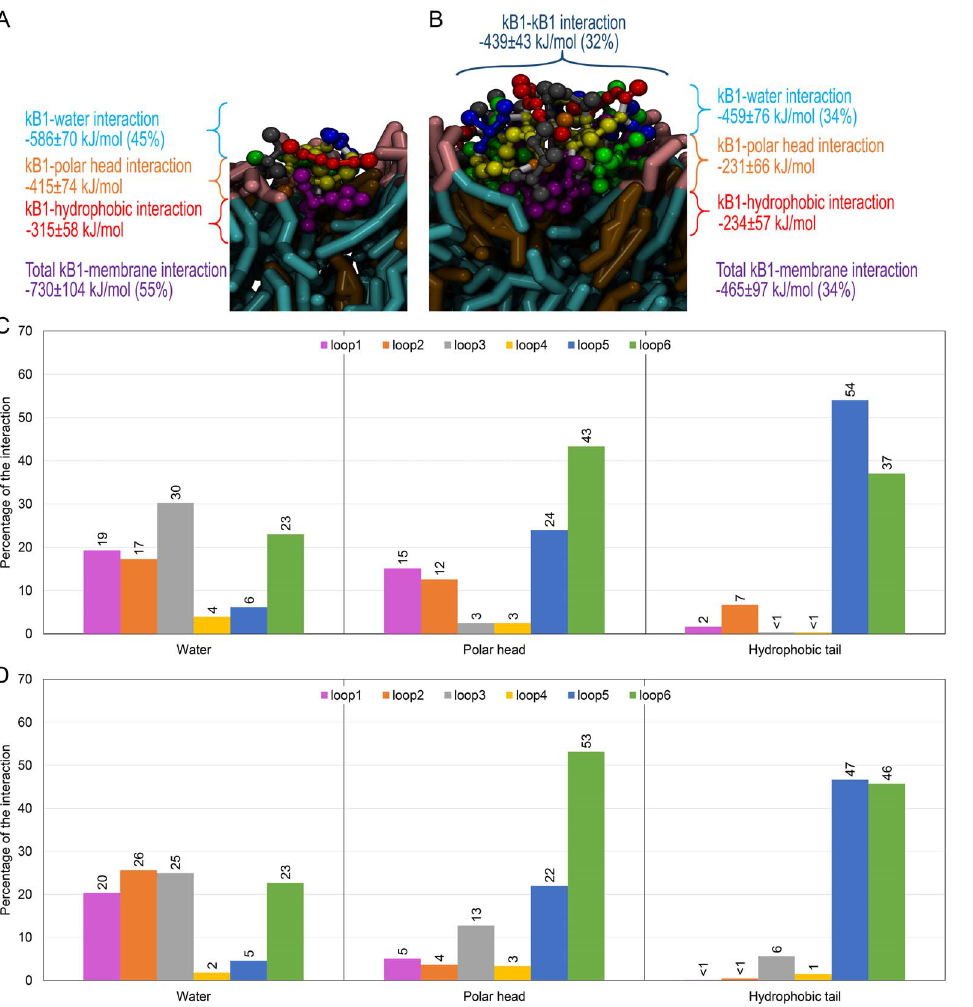
Figure 5. Interaction of monomeric and tetrameric kB1 in membrane-bound state. Average interaction energies of (A) monomeric and (B) tetrameric kB1 in the membrane-bound state are shown. In each parenthesis, the percentage of the interaction energy relative to the total interaction energy is presented. The structures are shown as the same model as inFigure 3. The interaction energy of each loop with water and with the membrane’s polar head and hydrophobic tail for (C) monomeric and (D) tetrameric kB1 are shown as percentages of the total interaction